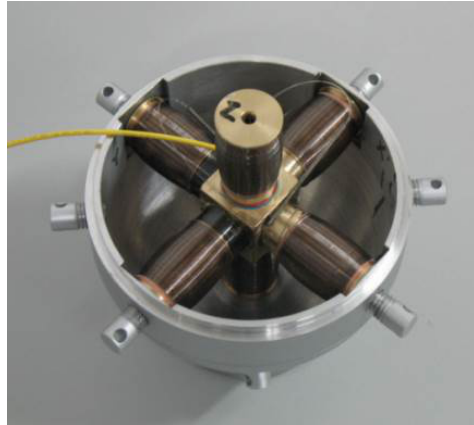
Fig. 7 Structure of FOVH.